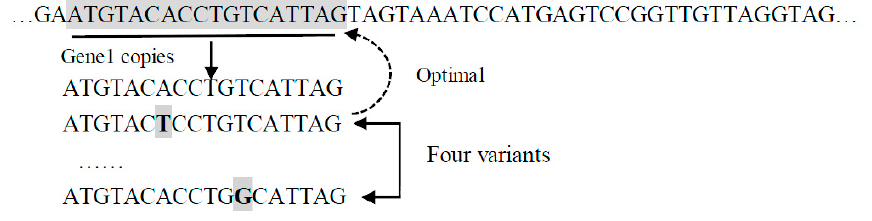
Figure 4. Pseudo bacteria genetic operation diagram.